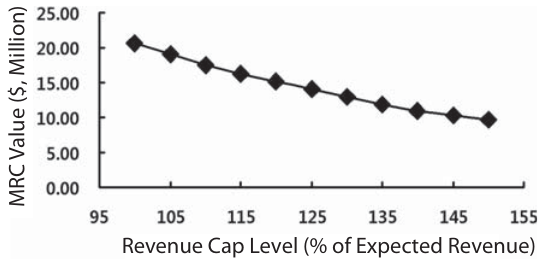
Figure 5. MRC value over MRG level (RCP: 90%).